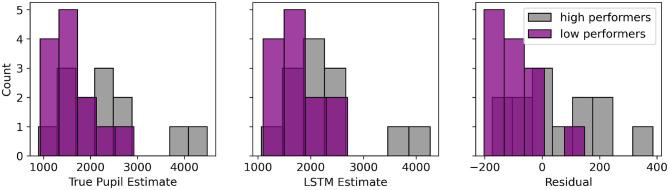
Histograms of true pupil diameter, LSTM estimates and residuals of the bottom (purple, n = 13) and top (gray, n = 13) tertile of participant performance on post-viewing assessments. The AUC is calculated for each measure. (AUCresiduals = 0.74, AUCLSTM = 0.63, AUCpupil = 0.65).